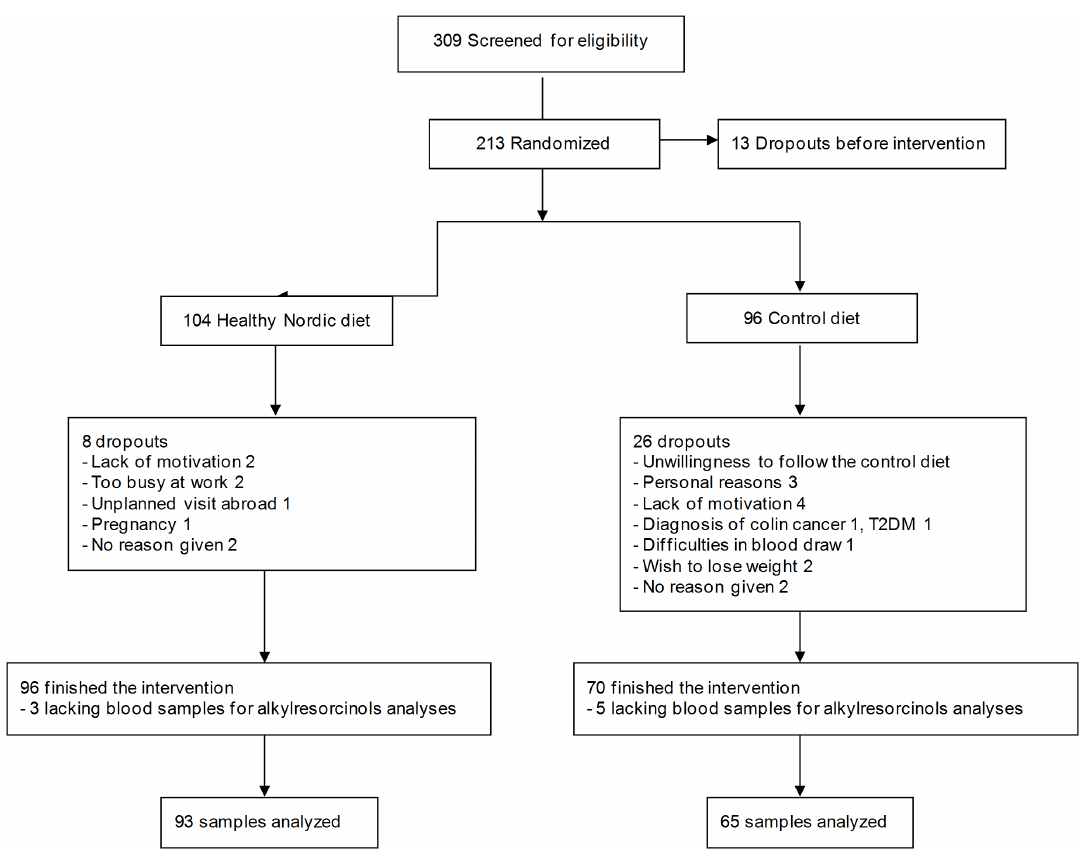
Figure 1. Flow chart of the study.